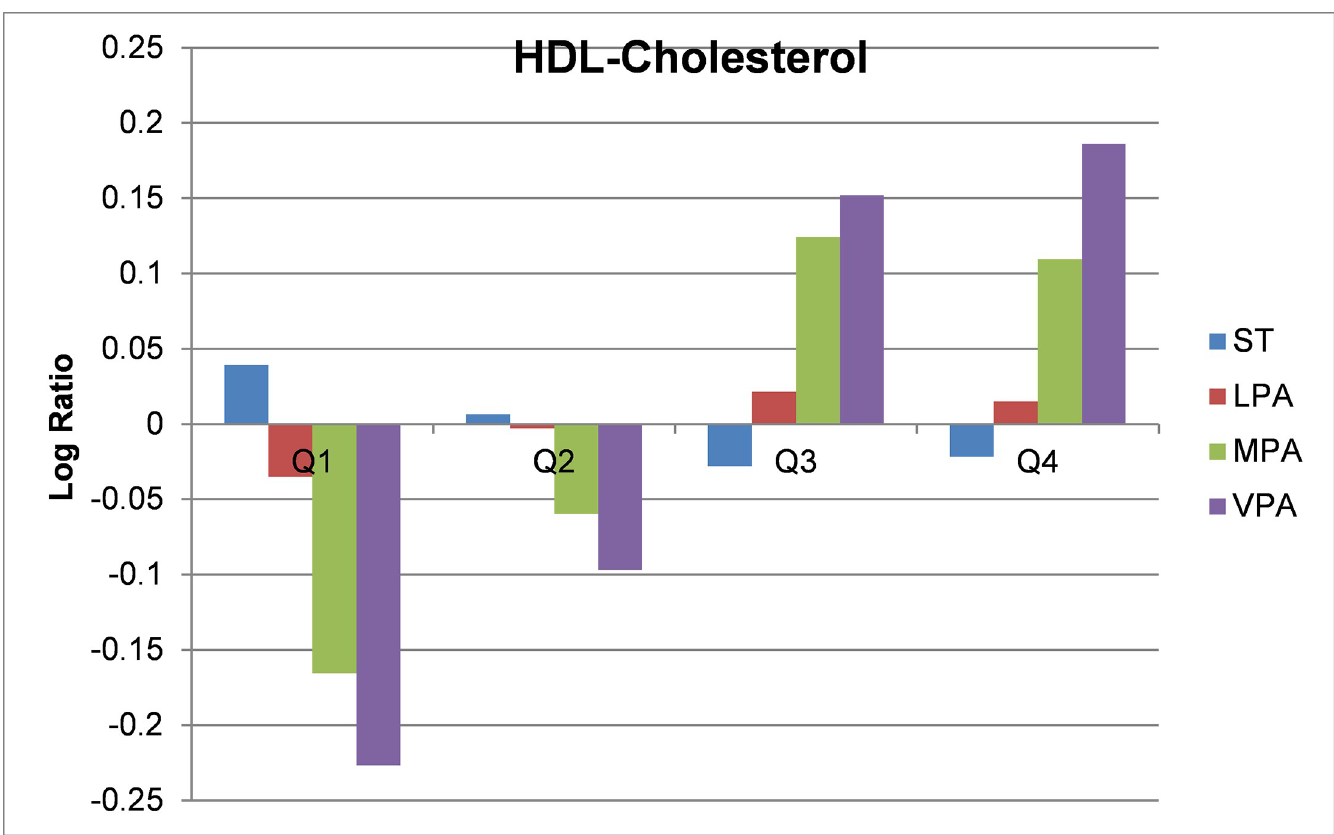
Fig 4. Compositional geometric mean bar plots comparing the compositional mean of the entire sample with the compositional mean of HDL-cholesterol quartiles subgroups for sedentary time (ST), light-intensity physical activity (LPA), moderate-intensity physical activity (MPA), and vigorous-intensity physical activity (VPA); HDL = High-density lipoprotein